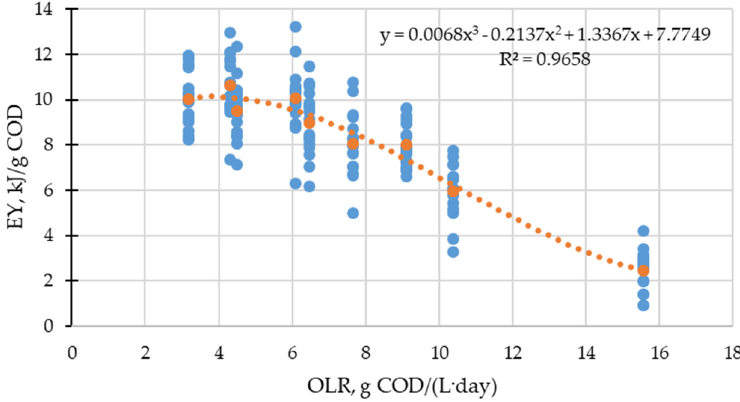
Figure 6. Dependence of EY on OLR: blue—experimental data for semicontinuous two-stage diges- tion; orange—mean values and model.